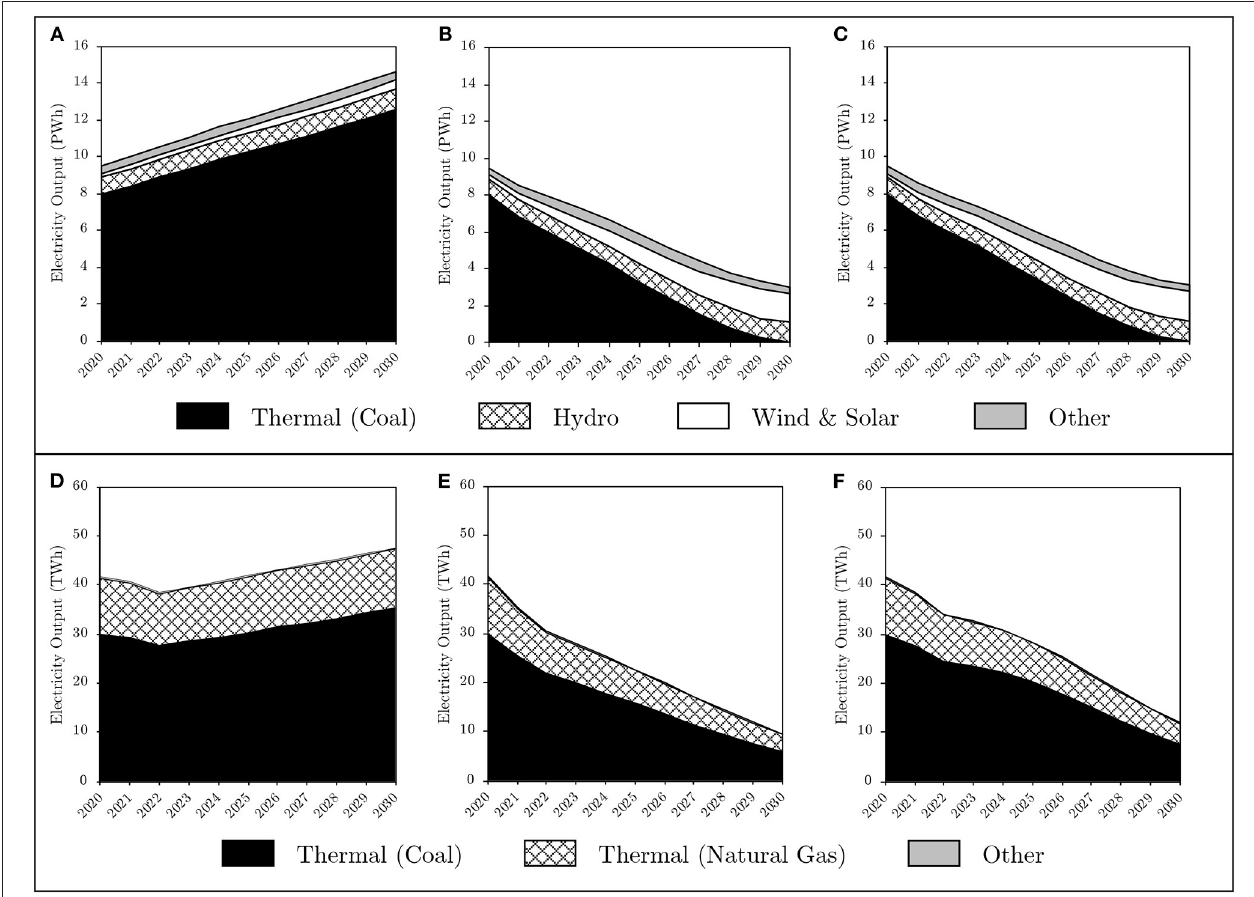
FIGURE 6 | Local electricity output mix under stringent mitigation scenarios: (A) China, BAU; (B) China, IPCC ; (C) China, IPCC_INT ; (D) Hong Kong, BAU; (E) Hong Kong, IPCC ; (F) Hong Kong, IPCC_INT